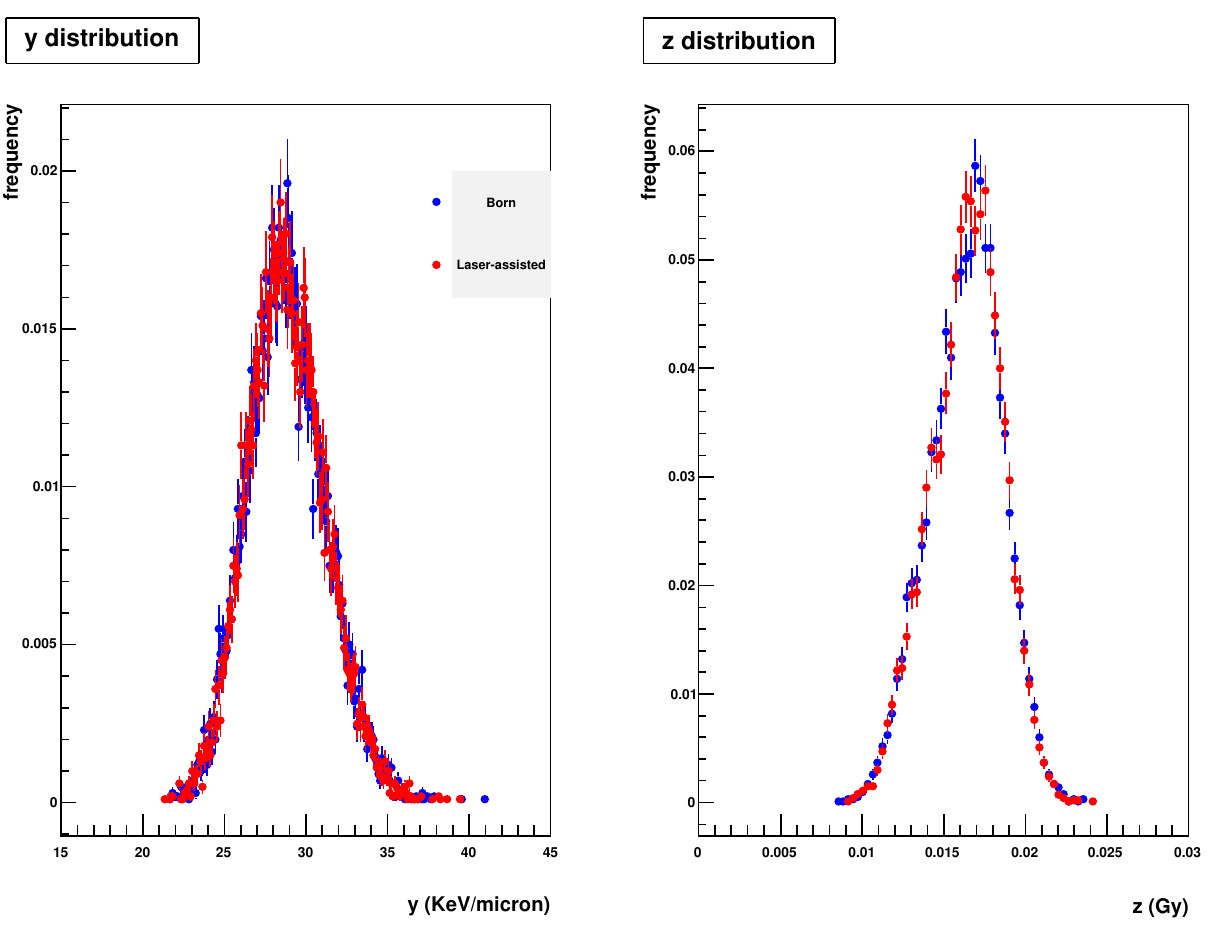
Figure 2. Simulated specific and lineal energy distributions for a 1 MeV irradiation of a micrometric volume (“cell nucleus”); • Born ionization process; • “laser-assisted” ionization